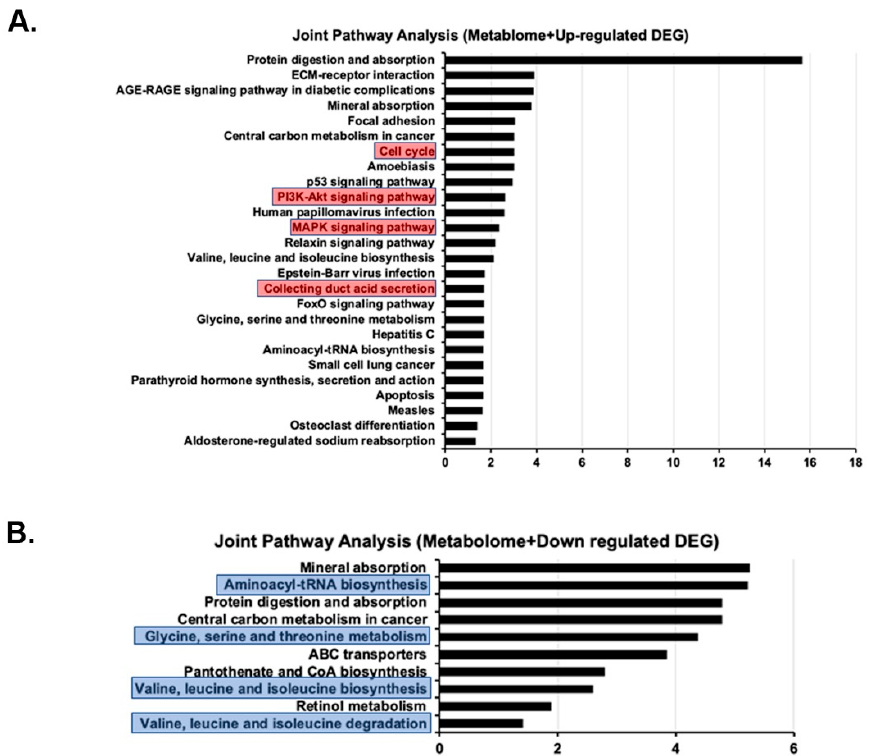
Figure 6. Joint pathway analysis using combined results of metabolomic and RNA-seq results. Combined examination of the metabolomic and RNA-seq data using the Metaboanalyst Joint Pathway Analysis function KEGG pathways most significantly (FDR < 0.05) affected by ( A ) up-regulated and ( B ) down-regulated genes were identified. Red boxes denote significant alterations in up-regulated pathways of importance, while blue boxes denote potentially down regulated pathways of potential significance.